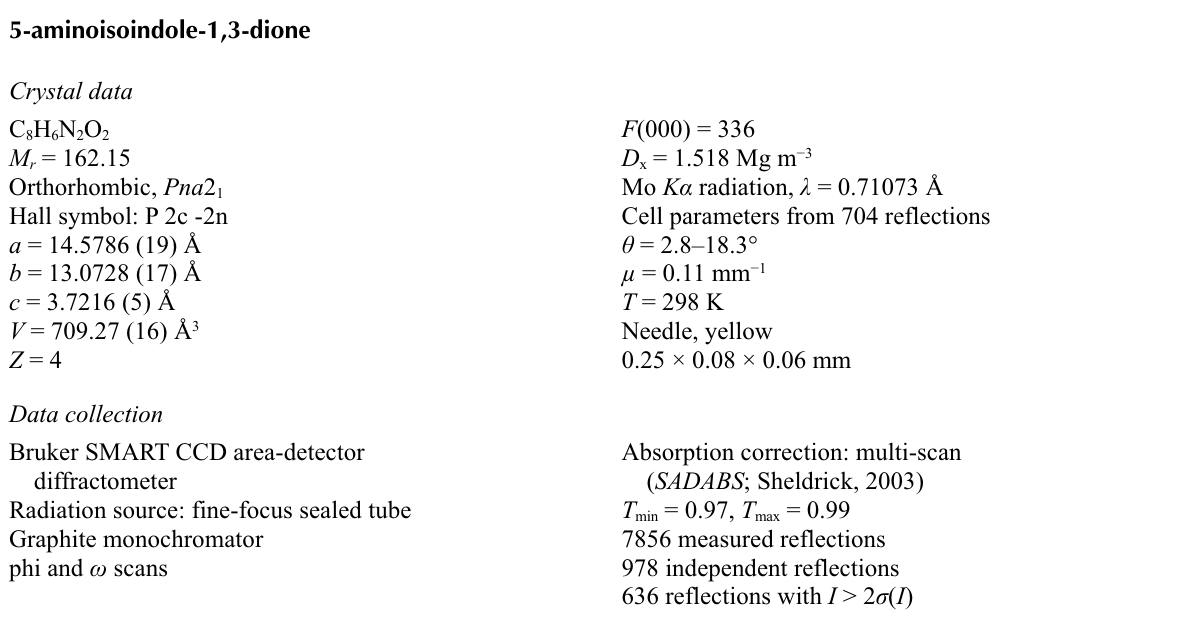
Packing diagram showing N—H···O intermolecular hydrogen bonds. [(1) N1—H1···O1 a , (2) N1 b – H1 b ···O1, (3) N2 c